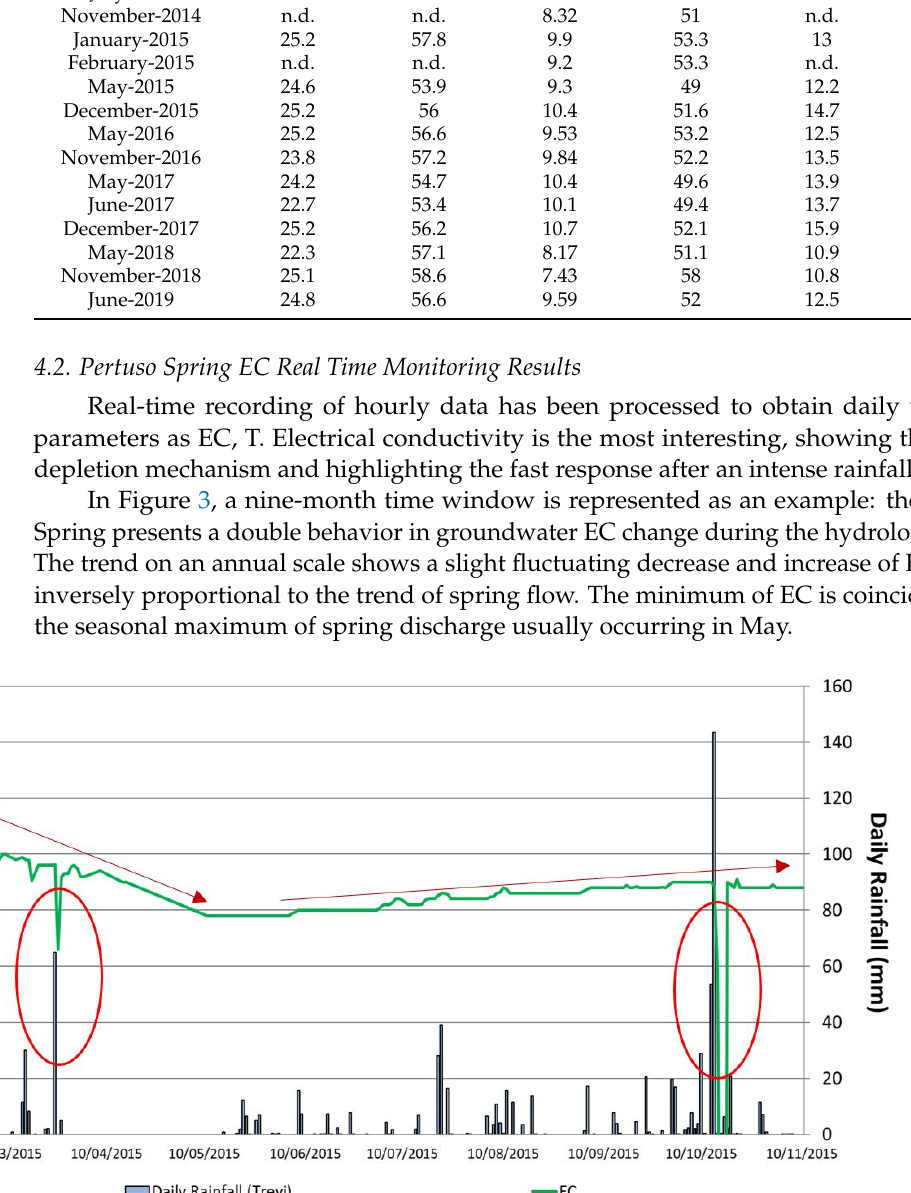
Table 2. Discharge values measured by traditional current-meter method at SW monitoring points (Q), at Pertuso Spring cross section (Q M ) and exploited rates (Q EX ). The sum of Q M and Q EX is the total spring discharge Q T . Date